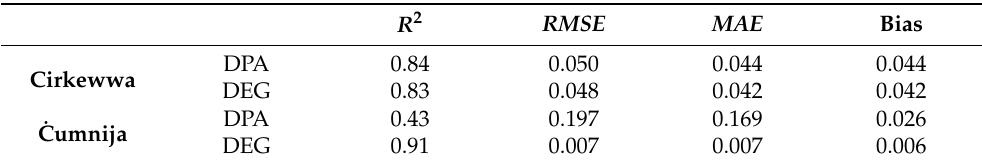
Table 1. Statistics calculated ( R 2 , RMSE , MAE and bias) for the linear regression models applied to the relationships between the UAV-retrieved reflectance data and the UAV photogrammetric reflectance data, comparing DPA and DEG methods.